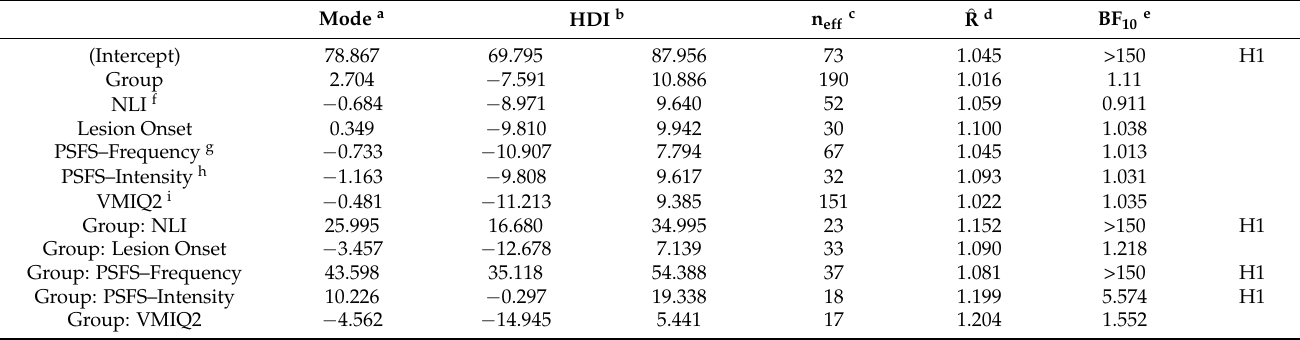
Table 3. Effects of clinical variables in modulation of PPS around lower limbs. Description as in Table